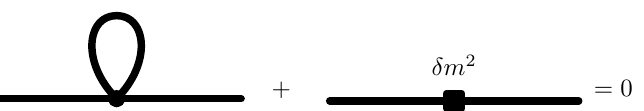
Figure 2 . The divergent one-loop diagram is exactly canceled by the mass counterterm. Within this scheme we can forget all the diagrams with lines that start and end at the same quartic vertex, their contribution being